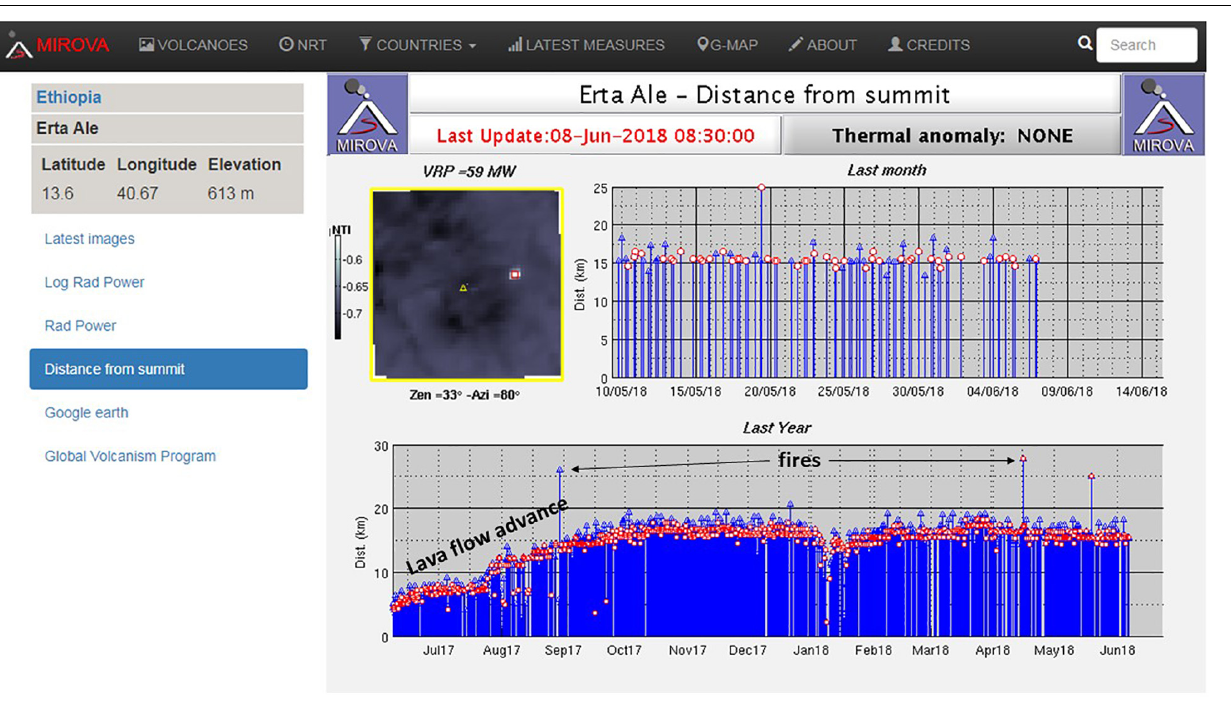
FIGURE 4 | Snapshot of the “ Distance from summit ” figure posted on MIROVA website for the Erta Ale volcano (accessed on 08 June 2018). Note the lengthening phase of the lava flow occurred between June and October 2017 with an average flow advancement velocity of 100 m day − 1 .